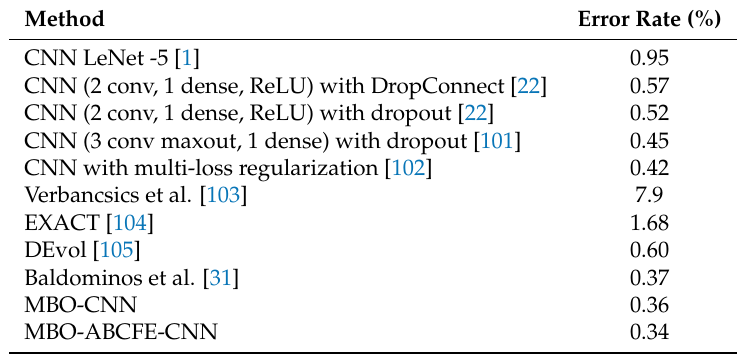
Table 9. Comparative analysis of the classification error rate on the MNIST